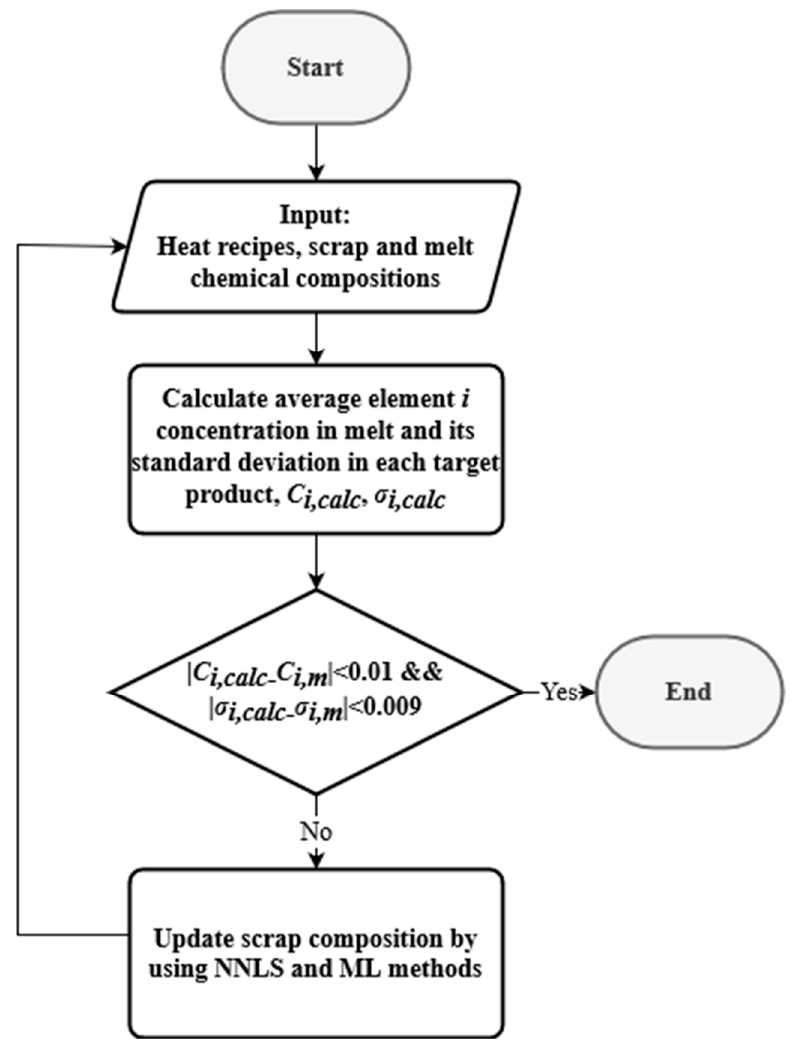
Figure 1. A flowchart of the procedure to estimate the accuracy of the scrap chemical composition.